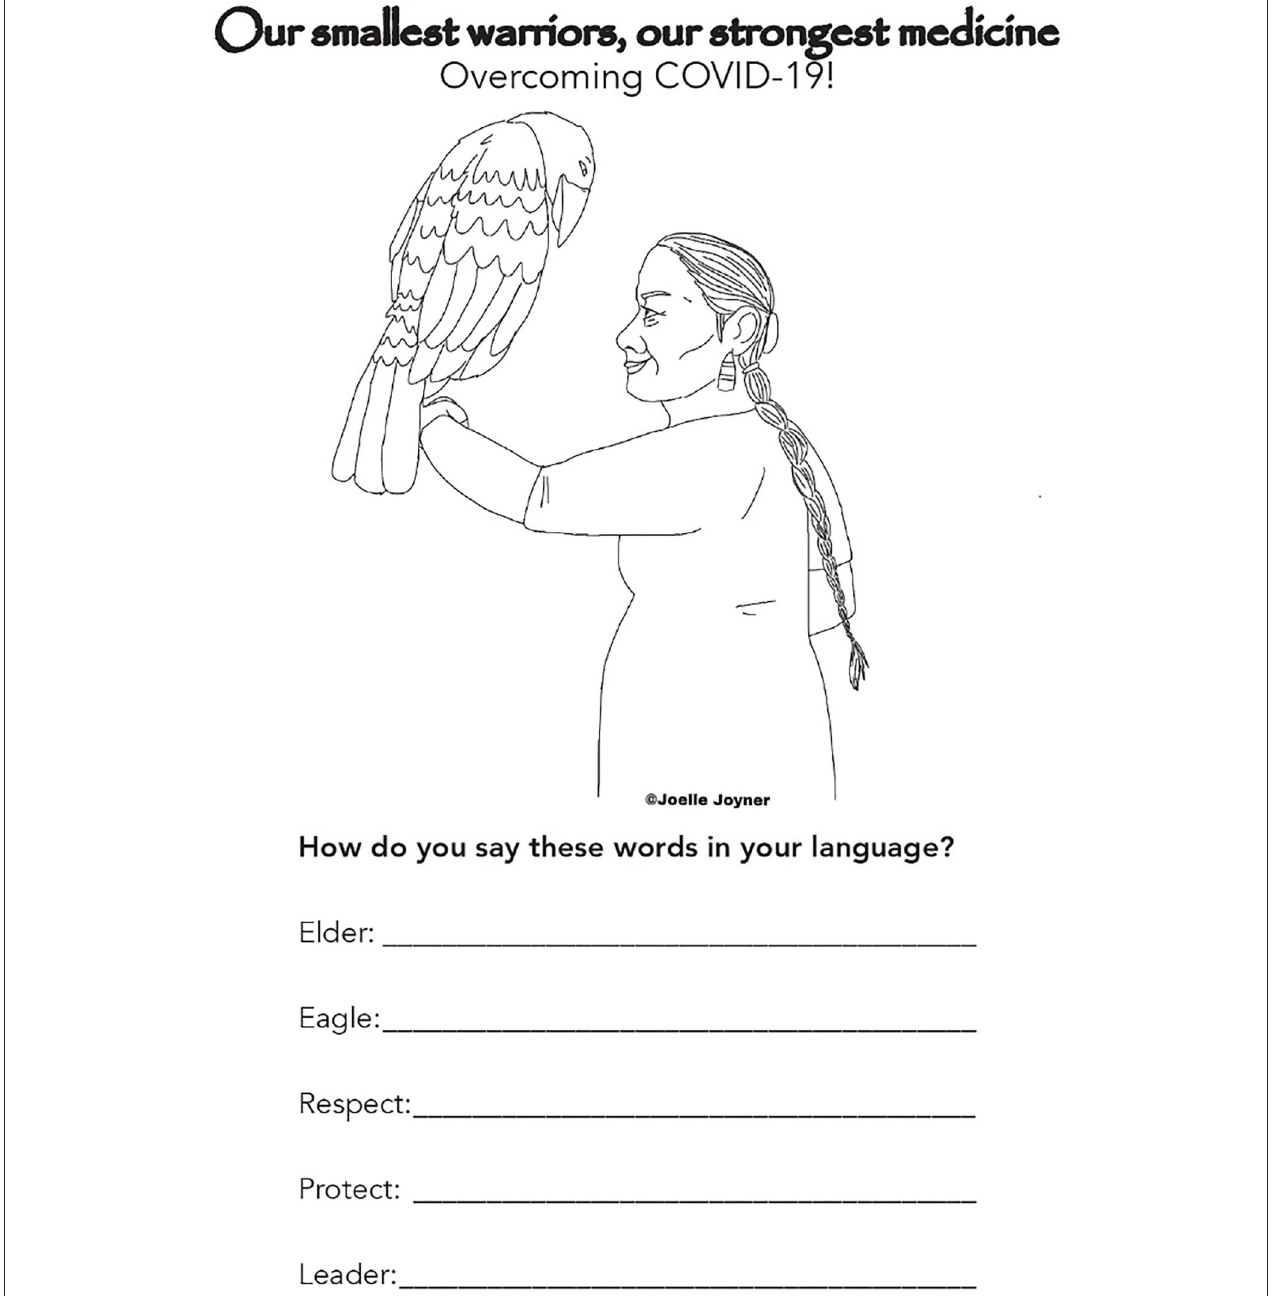
FIGURE 2 | Coloring and language resource developed by